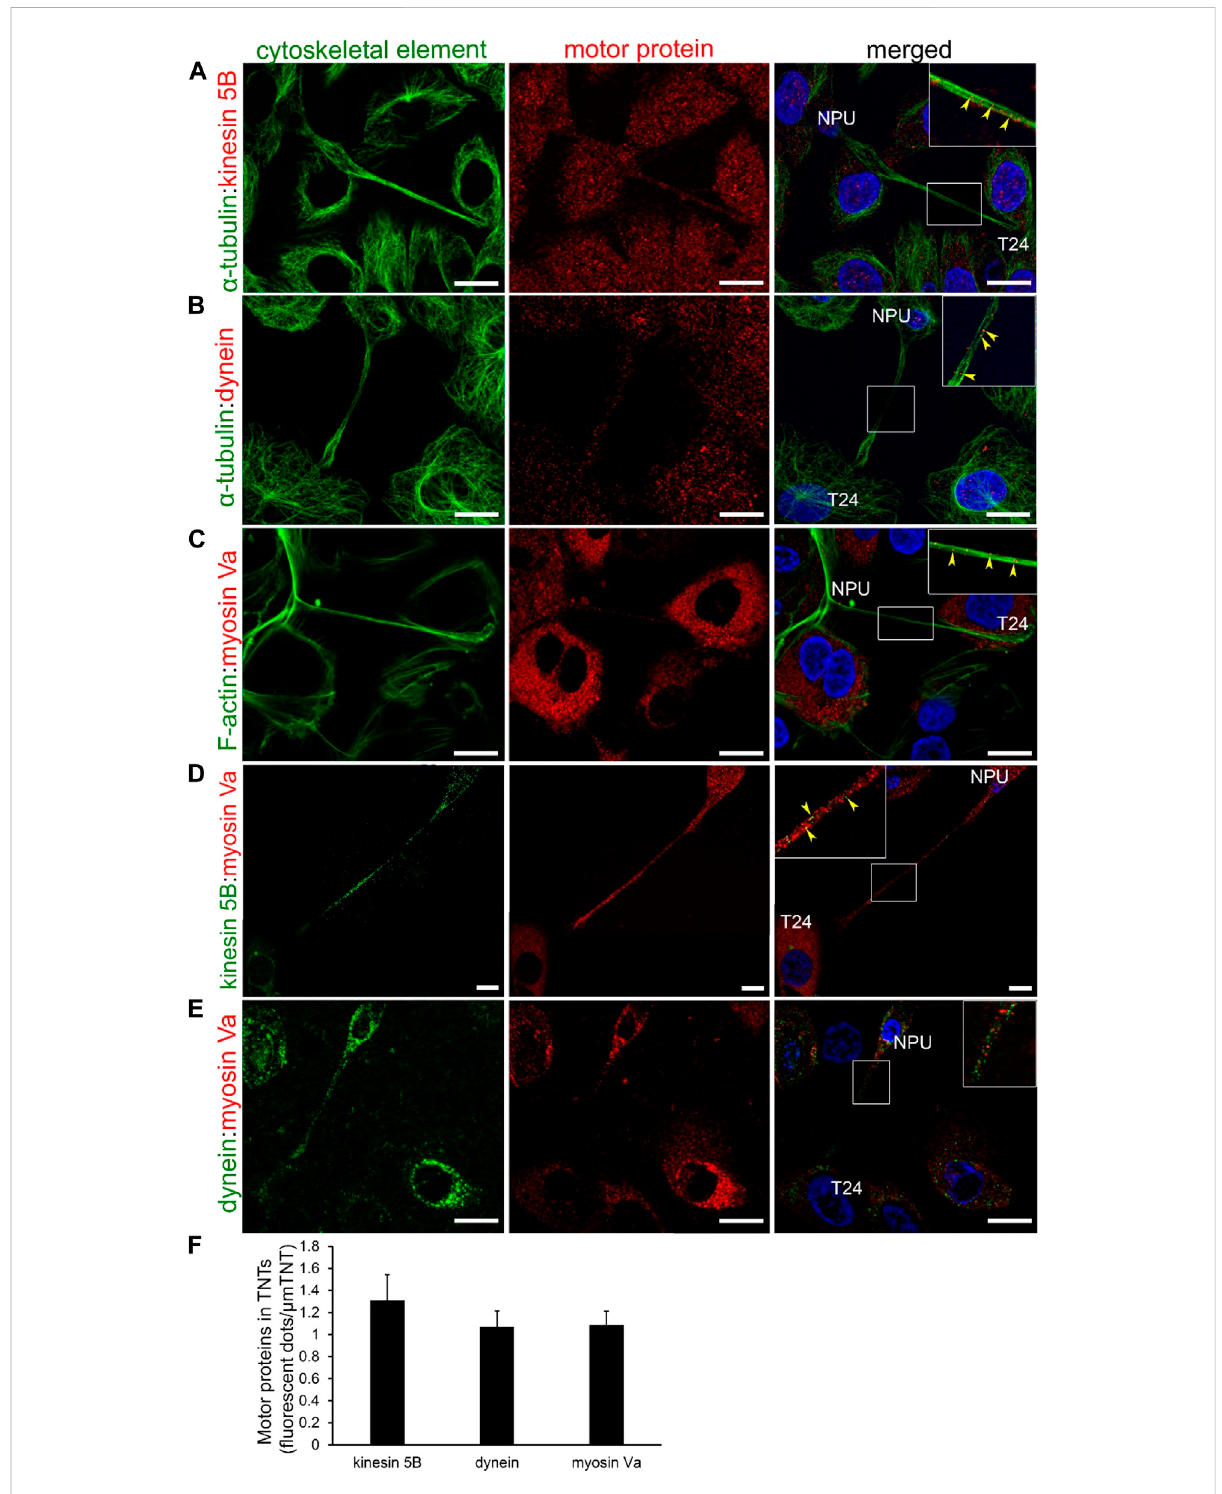
FIGURE 11 MotorproteinsTNTsincoculturesofnormal(NPU)andcancer(T24)urothelialcells.Motorproteinskinesin5B (A) ,dynein (B) ,andmyosinVa (C) with their associated cytoskeletal fi laments were present in TNTs. Co-distribution of both motor proteins kinesin 5B and myosin Va (D) and dynein and myosin Va (E) in TNTs as detected by double immuno fl uorescence. The inserts on the merged images are magni fi ed in the corners. The yellow arrowheadspointtothecolocalizationbetweentwomotorproteins (A – C) orbetweenmotorproteinsandcytoskeletalelement (DandE) .NPU and T24 cells are distinguished by the size of their nuclei (stained with DAPI). Scale bars: 20 μ m. (F) Quanti fi cation of fl uorescent dots for expression of individual motor protein in heterocellular TNTs (mean of fl uorescence dots/ μ m of TNT ± SEM; kinesin, n = 12; dynein, n = 16; myosin, n = 10).